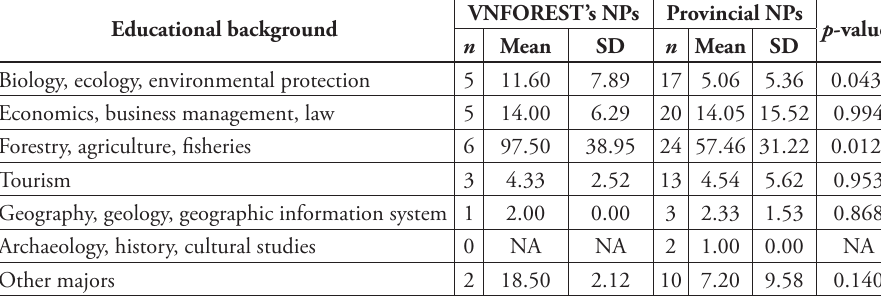
Table 8. Groups of national park staff by educational background